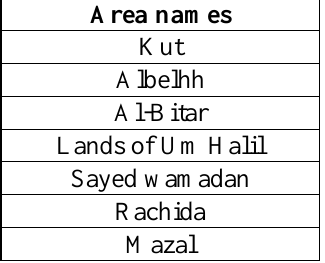
Table 2: Producing area names of